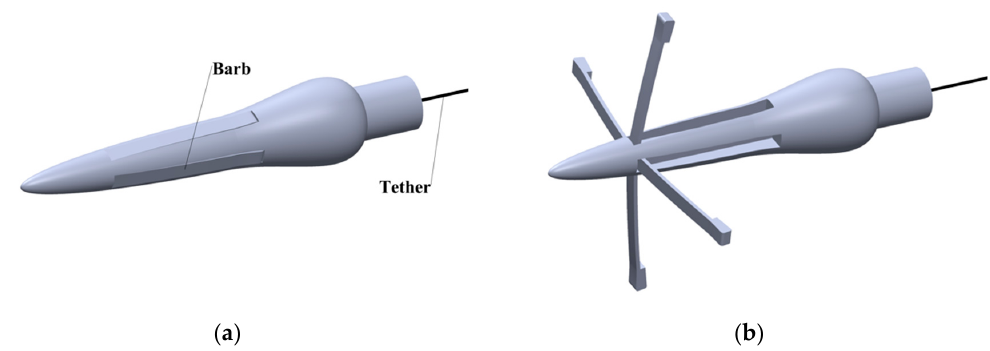
Figure 6. The harpoon payload when the barbs are ( a ) inactive and ( b ) active.